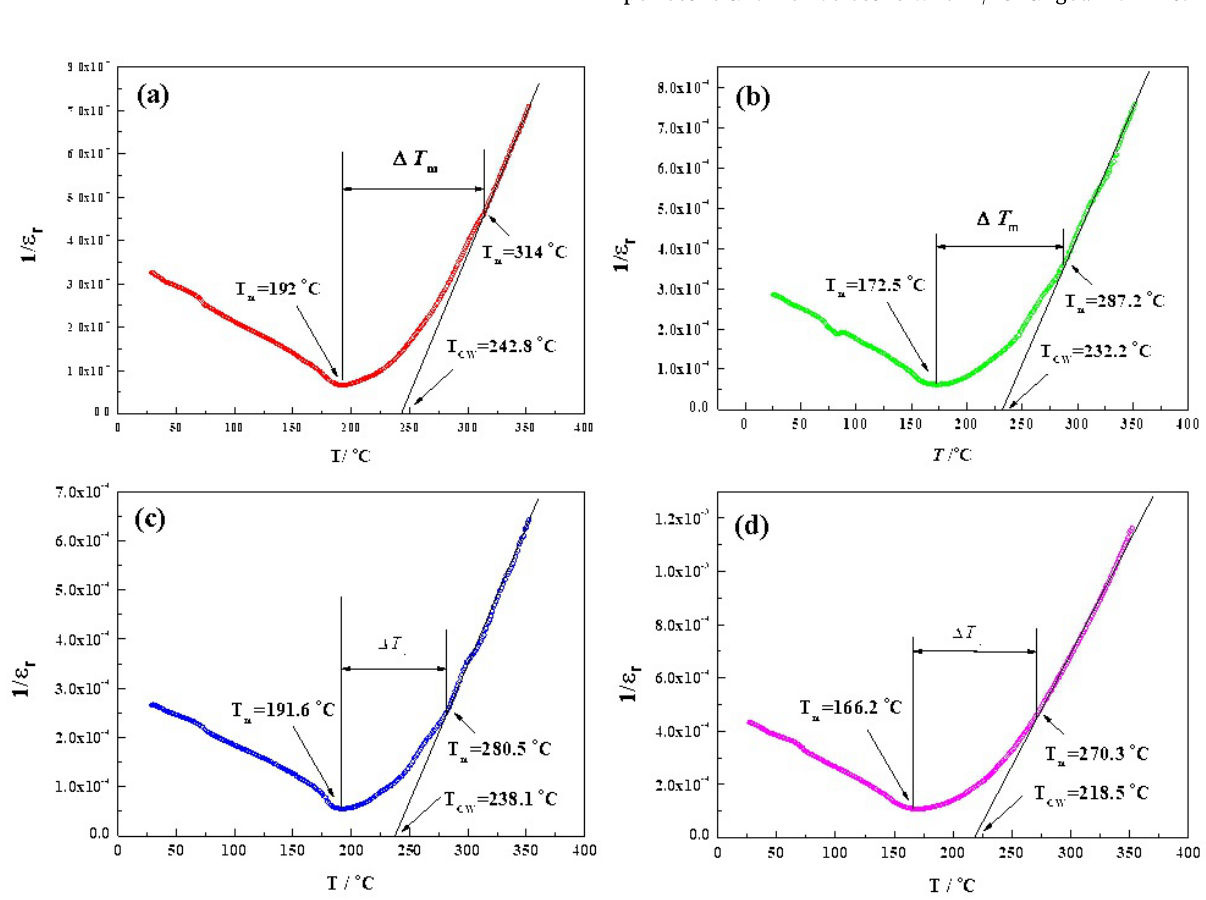
Figure 4: Inverse permittivity as a function of temperature for ceramics at 100 kHz (a) x = 0.1, y = 1; (b) x = 0.1, y = 2; (c) x = 0.2, y = 1; (d) x = 0.2, y =